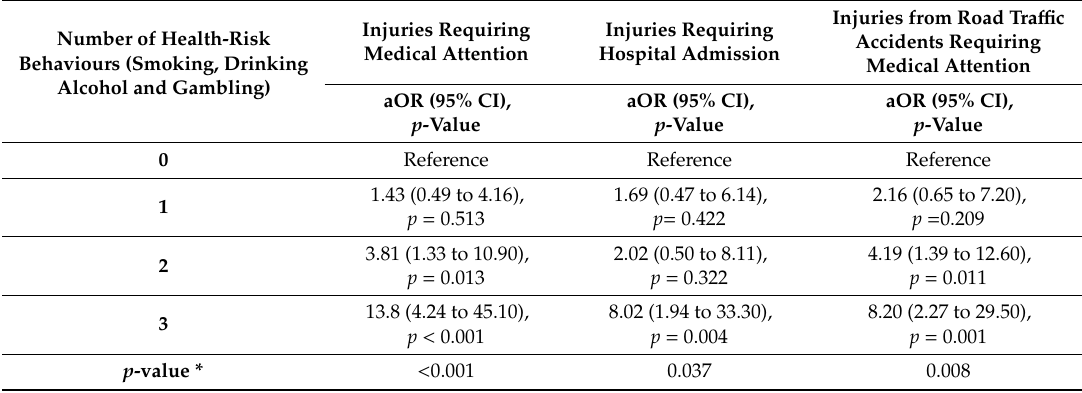
Table 4. Associations between the number of health-risk behaviours and